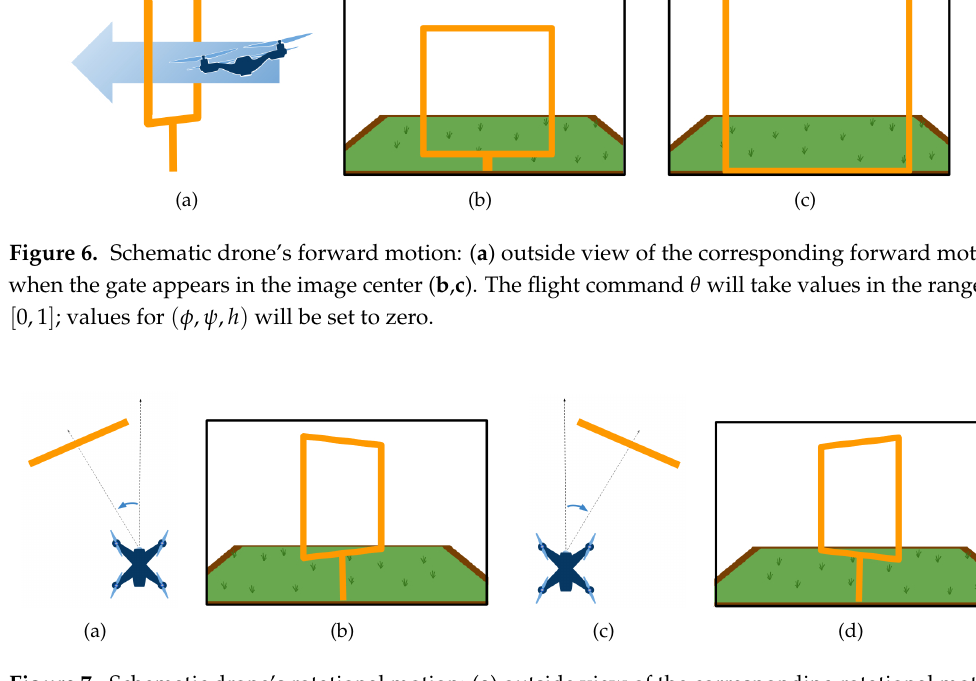
Figure 7. Schematic drone’s rotational motion: ( a ) outside view of the corresponding rotational motion in the yaw angle when the gate appears skewed towards the right of the image ( b ); ( c ) corresponding yaw motion when the gate appears skewed towards the left of the image ( d ). The flight command ψ will take values in the range of [ − 1,1 ] ; values for ( φ , θ , h ) will be set to zero.